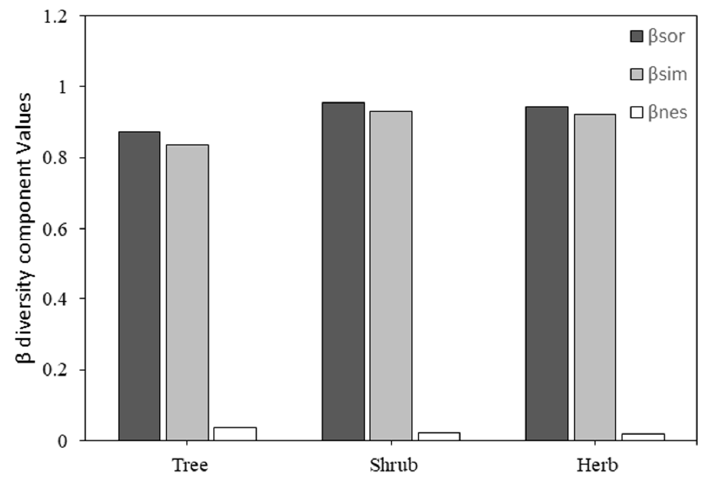
Figure 2. β -diversity and components of different plant forms of the Nanling Mountains. Figure 2. β - diversity and components of different plant forms of the Nanling Mountains.